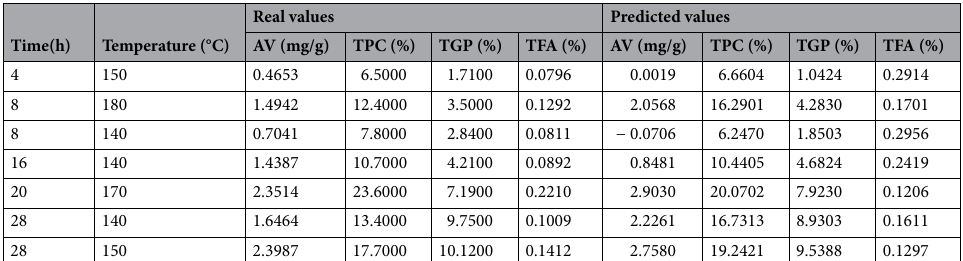
Table 1. The real values versus the predicted values of chosen indicators. If one of the values surpasses the threshold, we determine that the oil will deteriorate on that condition. The thresholds of indicators are set to: ( AV threshold , TPC threshold , TGP threshold , TFA threshold ) = ( 5, 27, 10, 2 )